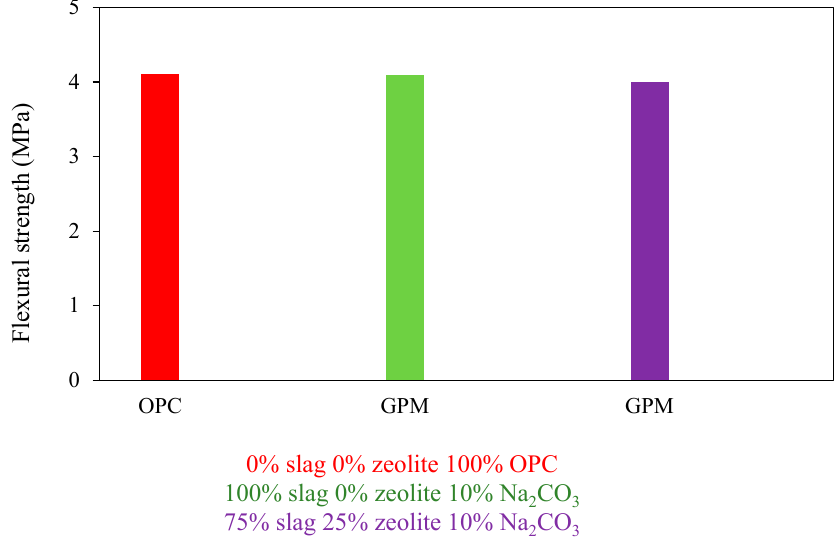
Figure 12. Flexural strength comparison between GPM and PCM.